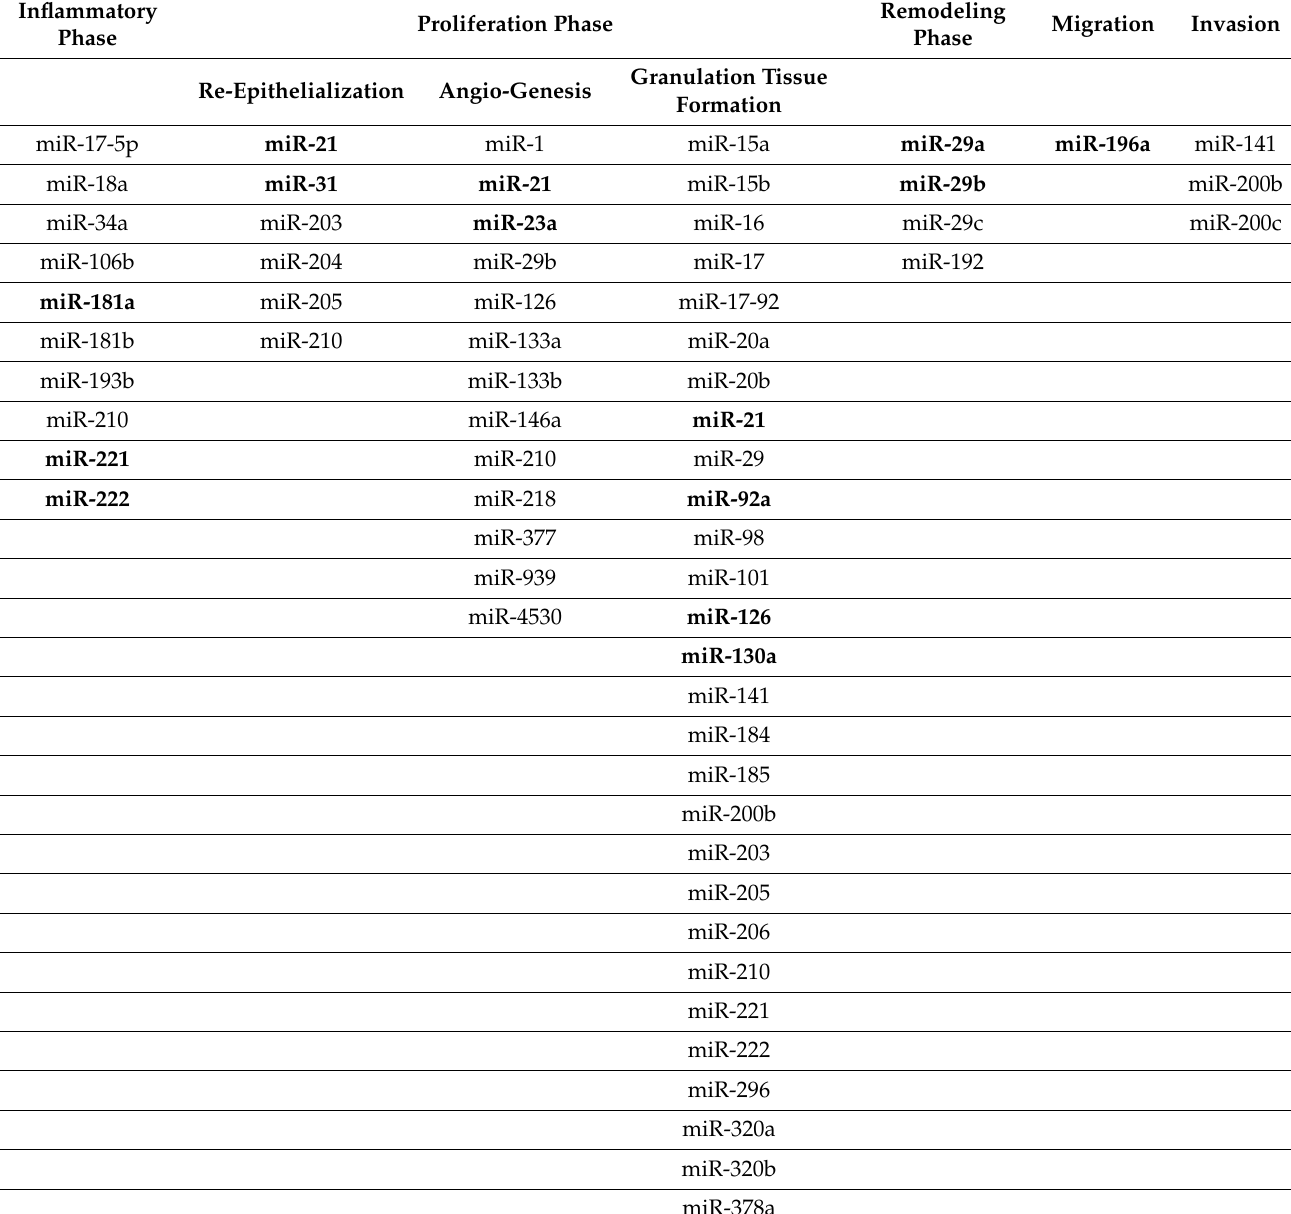
Table 7. List of miRNAs involved in the various stages of wound healing. Highly expressed microRNA are bolded